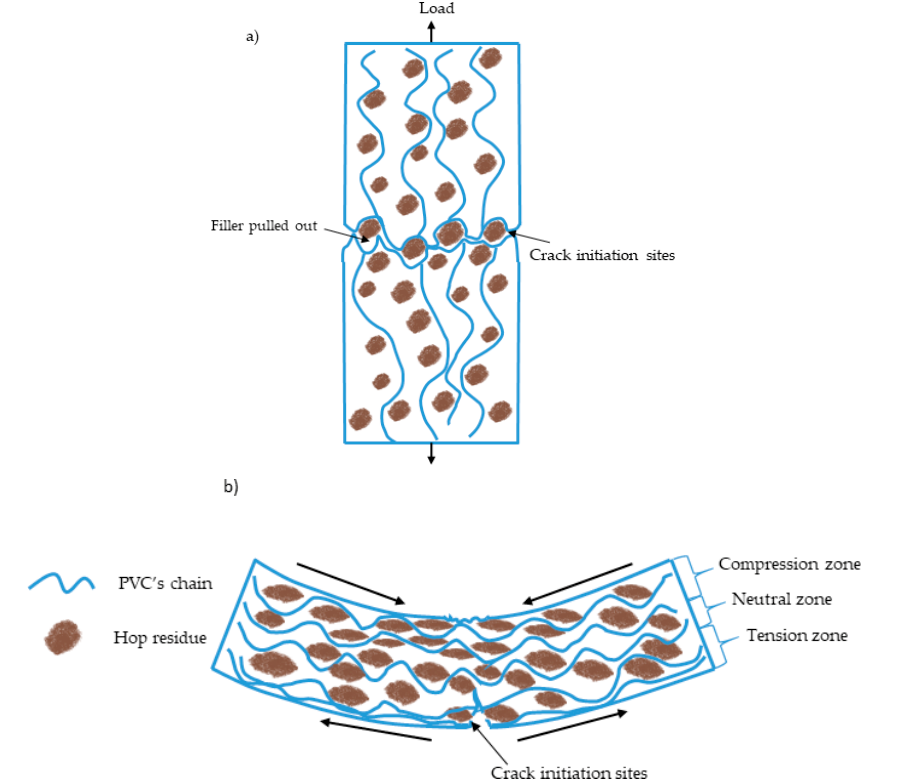
Figure 9. An illustration of the possible fracture mechanism of PVC/H composites in tension ( a ) and bending ( b ).